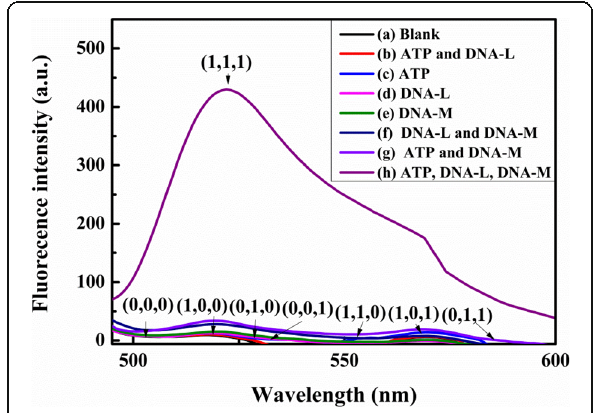
Fig. 1 Fluorescence spectrum: a PicoGreen dye, GO. b PicoGreen dye, GO, DNA-L, 100 μ L of 10 mM ATP. c PicoGreen dye, GO, 100 μ L of 10 mM ATP. d PicoGreen dye, GO, DNA-L. e PicoGreen dye, GO, DNA-S. f PicoGreen dye, GO, DNA-L, DNA-S. g PicoGreen dye, GO, 100 μ L of 10 mM ATP, DNA-S. h PicoGreen dye, GO, 100 L 10 mM ATP, DNA-L,